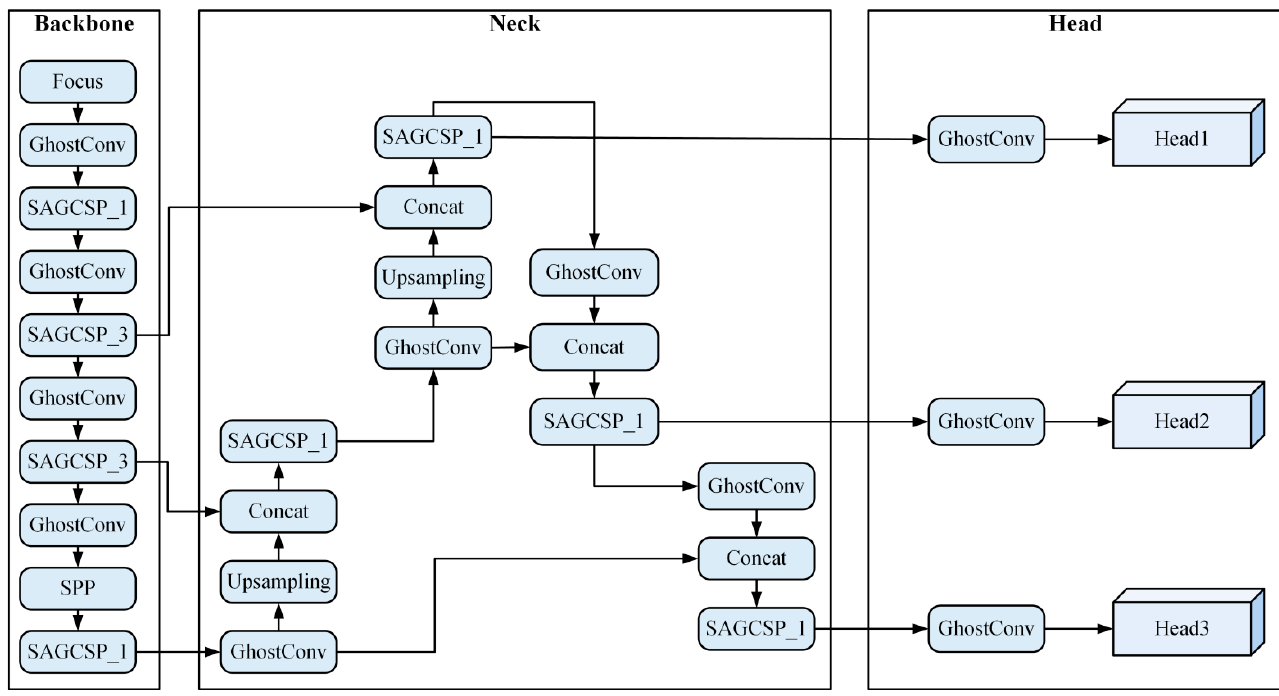
Figure 4. SAG-YOLOv5s object detection network.